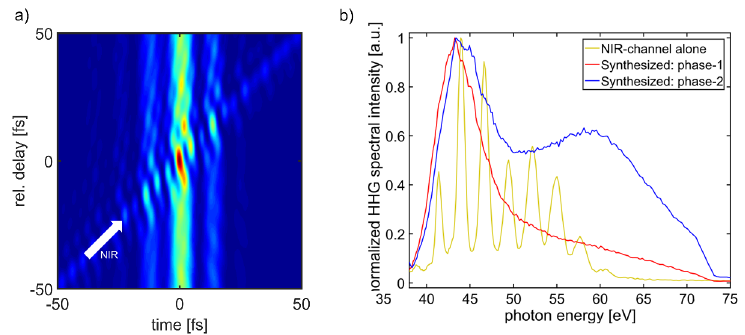
channel. (b) HHG spectra of single NIR channel (yellow) and both channels with di ff erent relative phases (blue, red) indicating the transition from comb like harmonics to a single continuum depending on the temporal overlap of both